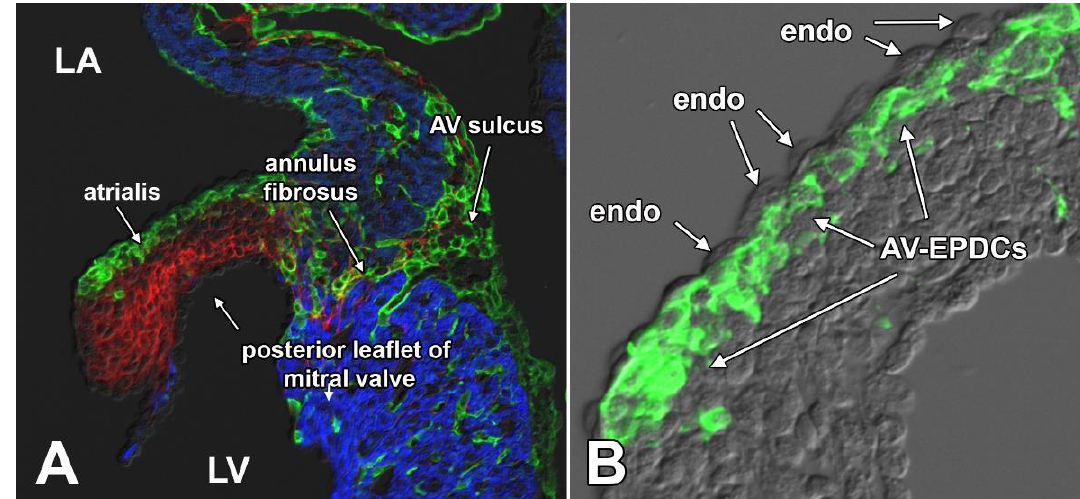
Figure 4. AV-EPDCs migrate into and occupy the subendocardial space at the atrial side of the left parietal leaflet (posterior leaflet of mitral valve). This figure shows the left AV junction of a ~16 ED Wt1 cre ;R26 mG heart. The section shown in ( A ) was stained for myosin heavy chain (MF20, blue), EGFP expression to delineate EPDCs (green), and periostin (red). Panel ( B ) shows a detail of the leaflet, only showing the EGFP expression, demonstrating that the EGFP-positive AV-EPDCs are located immediately below the endocardial lining of the leaflet. LA, left atrium; LV, left ventricle; endo, endocardium.